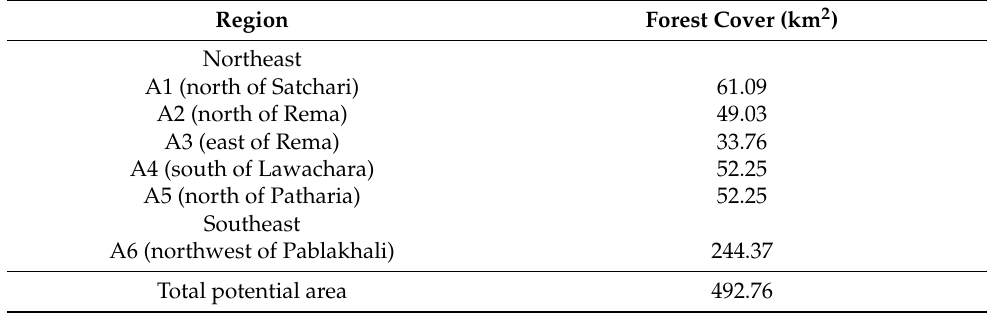
Table 4. Areas identified to have suitable forest cover to support western hoolock gibbon populations based on MaxEnt